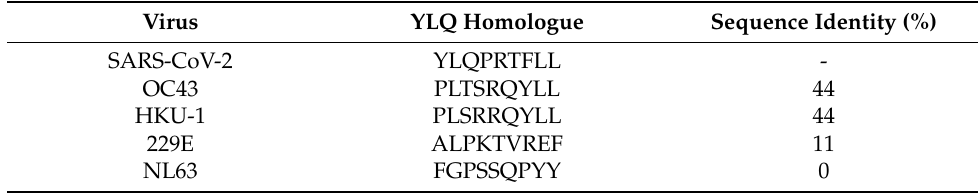
Table 1. YLQ homologues peptides from seasonal